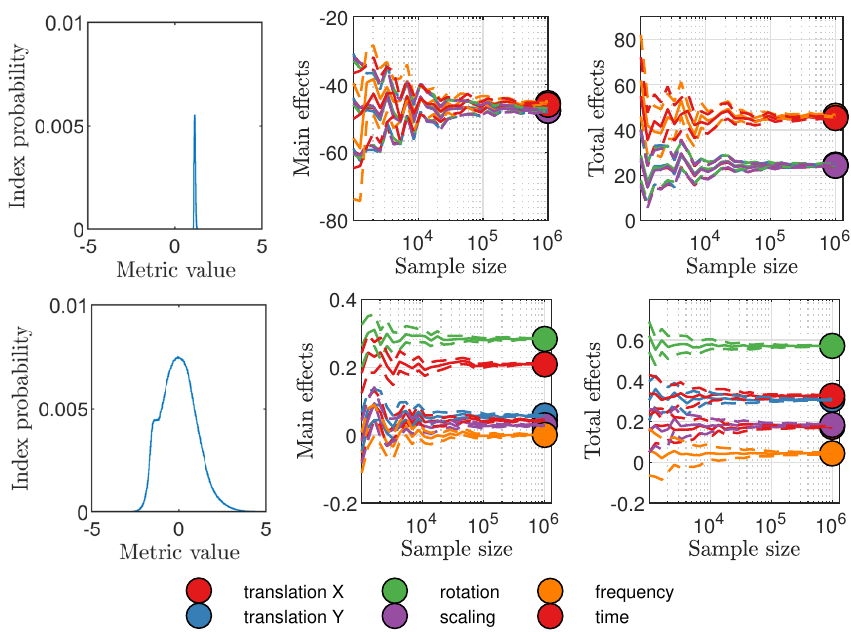
Figure 4. Effect of centering model output distributions computed during GSA. The top row shows sensitivity indices and their convergence obtained with the original distribution. The bottom row shows results achieved after centering the model output distribution. Mean values (solid lines) and confidence bounds (dashed lines) were estimated using bootstrapping with 500 resamples. Example results for Studholme’s Mutual Information (SMI) in Scenario